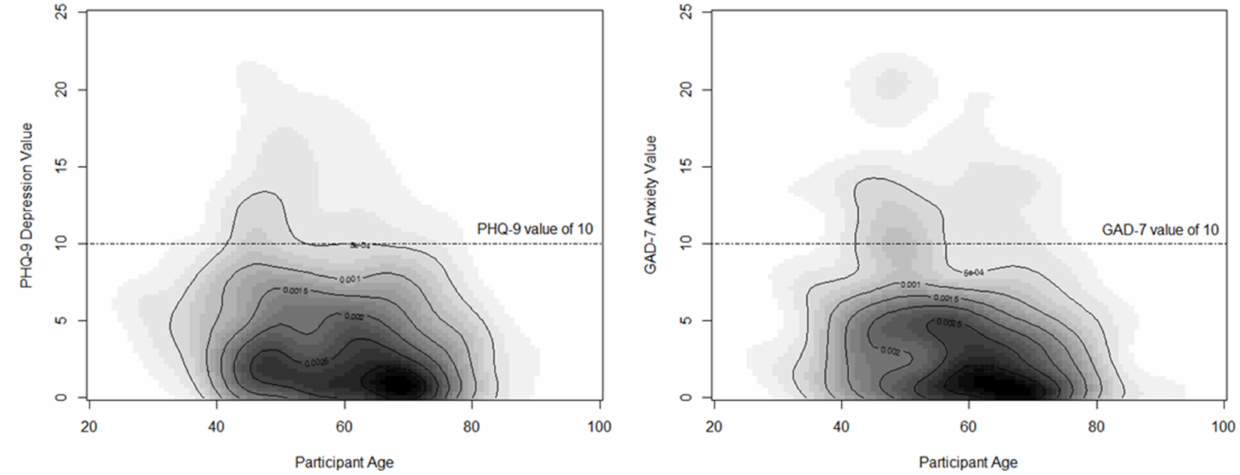
Figure 1. Panel plot of participants reporting symptoms of depression (PHQ-9) 7 and anxiety (GAD-7) that exceeded clinical thresholds. 7 Abbreviation: PHQ-9, Patient-health questionnaire-9; GAD-7, Generalized Anxiety Disorder. Table 4. Results of regression analyses of PHQ-9 values and GAD-7 values, adjusting for participant’s age, comorbidities, procedure, and SES.